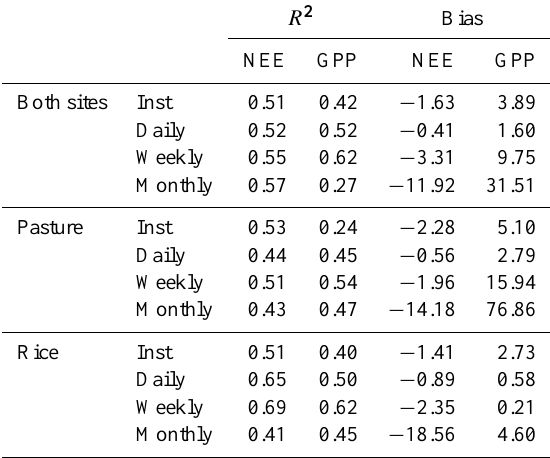
Table 2. Independent Validation data set fit for mean PLSR mod- els. We calculated the R 2 and bias between the predicted CO 2 flux variables with the mean PLSR models and the actual measurements from the 20% of data left for Independent Validation. Units for in- stantaneous (Inst) fluxes are µmolm − 2 s − 1 , and for daily, weekly, and monthly values are gCm − 2 . The highest predictive fit for the PLSR models was achieved with the data set that included the Rice data